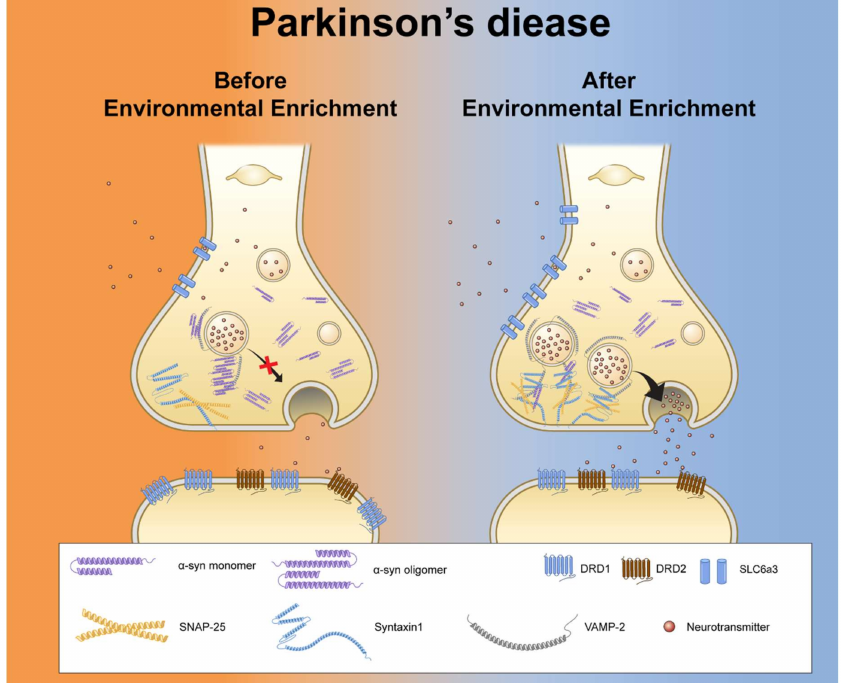
Figure 5. Synopsis of the amelioration of aberrant synaptic signaling in hA53T α -Syn-overexpressing transgenic mice by EE. This schematic illustration summarizes the progressive pathology of dopamin- ergic nerve terminals in the striatum and NAc in PD. Initially, the functions of SNAP-25, syntaxin1, and VAMP2 help synaptic vesicles to dock and fuse to permit exocytosis. These functions are inter- rupted by aggregated α -Syn proteins; therefore, dopamine release decreased in the mice from the PD-SC group. As a compensatory effect, the expression of Drd1 increased, enabling the reception of more synaptic signals. EE simultaneously reduced the levels of aggregated α -Syn and enhanced the expression of SNARE proteins, such as syntaxin1 and VAMP2. SNARE proteins may recover their functions. Finally, synaptic vesicles were re-circulated and normalized; thus, cytosolic dopamine levels may be normalized in the NAc. Since the activities of dopamine transporters and/or dopamine receptors were normalized, pre-motor symptoms were ameliorated, and the progression of the disease could be